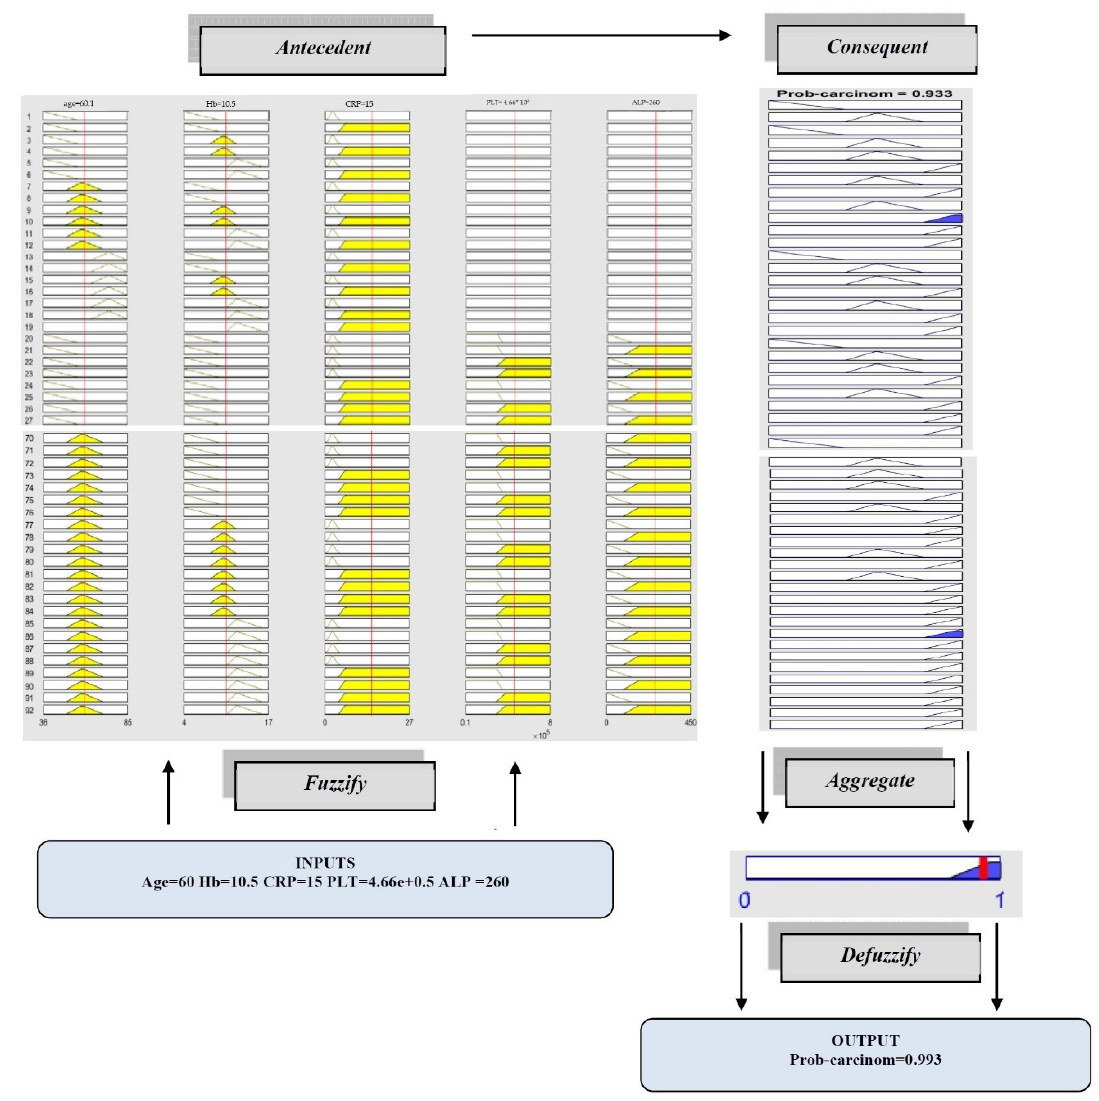
Figure 11. Fuzzy inference system.